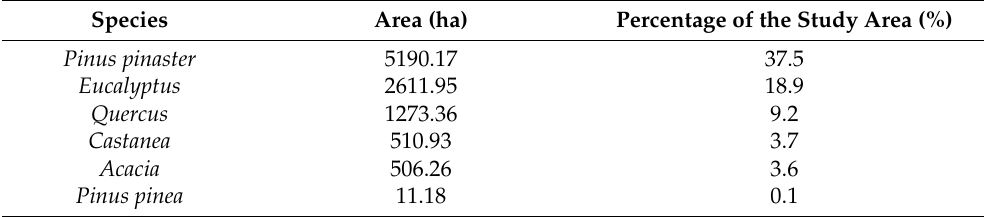
Table 3. Dominant species represented in ha and percentage adapted from